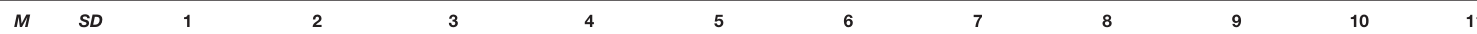
TABLE 1 | Means, standard deviations, and correlations with confidence intervals of all study variables.